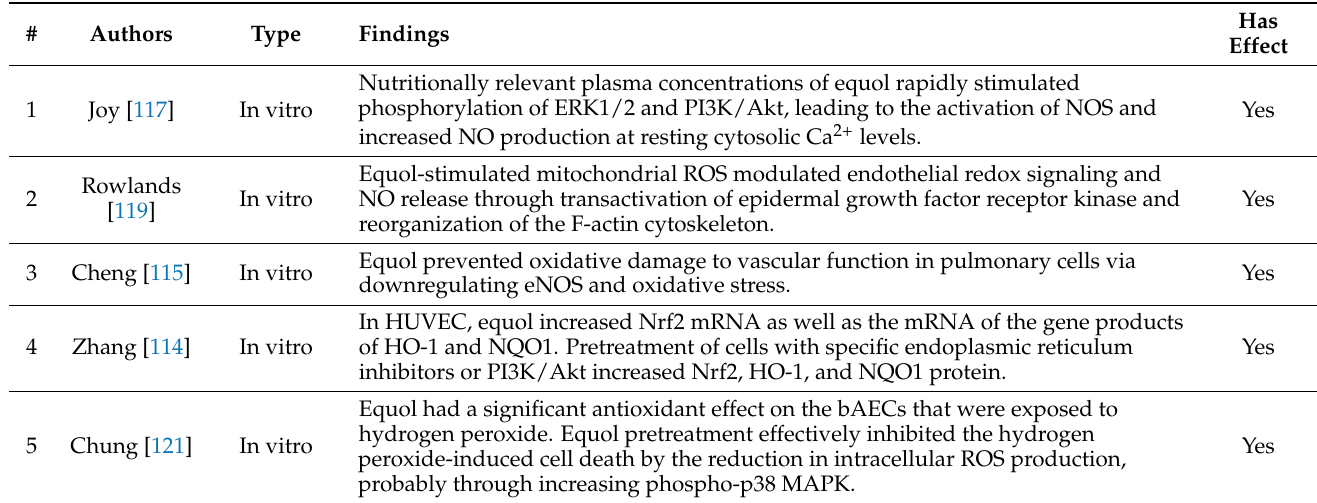
Table 3. Endothelial function improvement effects of